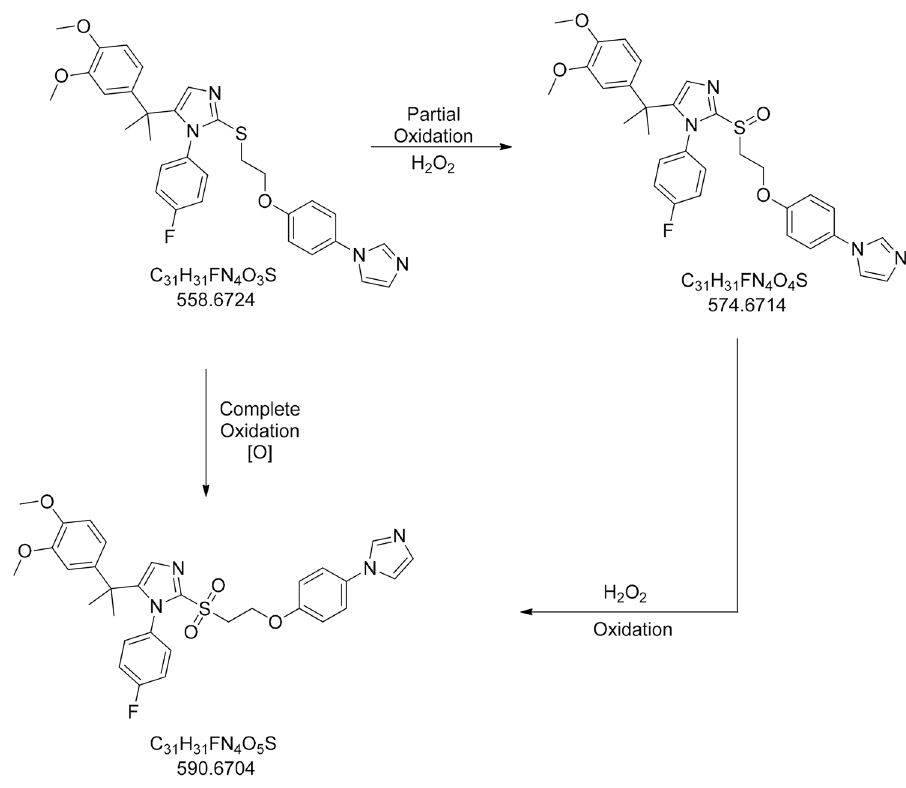
Fig. 2 Oxidation degradation pathway of